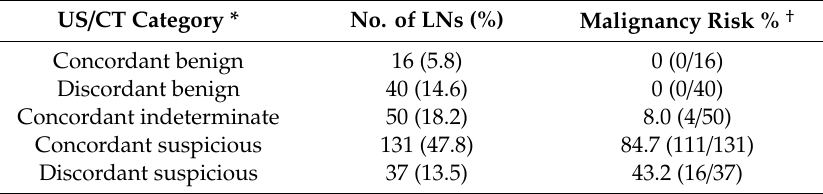
Table 4. Concordance between the US and CT categories.